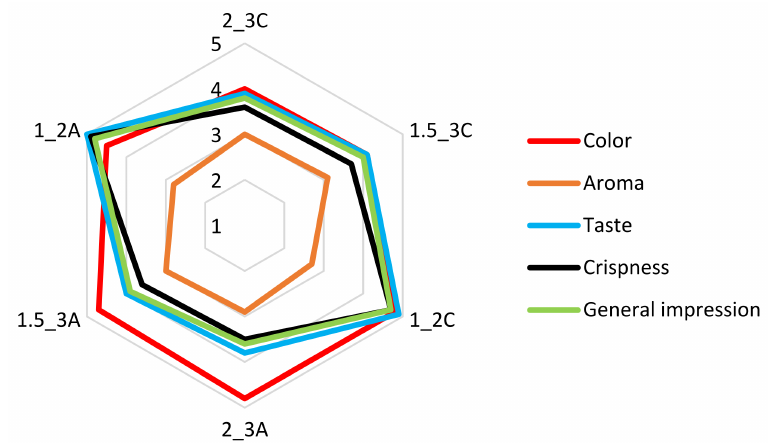
Figure 8. The average results for the organoleptic discriminants of fruit snack. Denotations in Table 1 include Index (A) next to the sample symbol—bars with the apple pomace, Index (C) next to the sample symbol—bars with the chokeberry